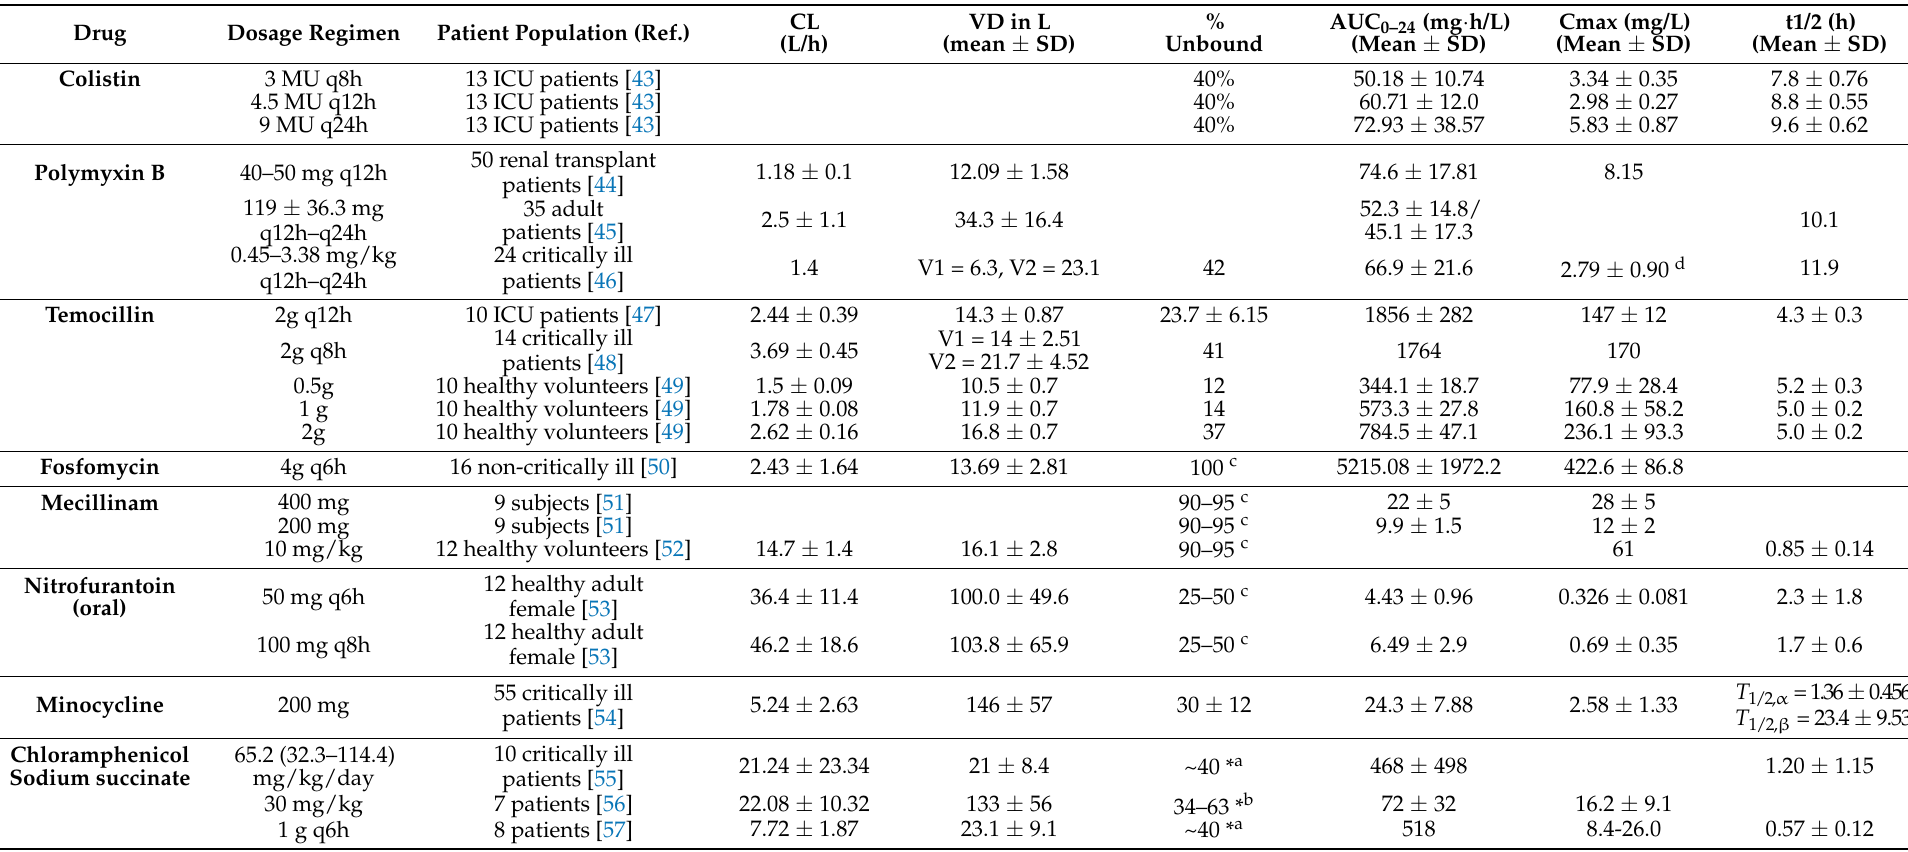
Table 2. Clinical pharmacokinetics of old